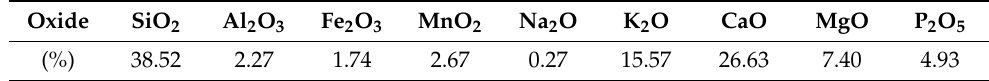
Table 1. Oxide composition of used fir wood ash.